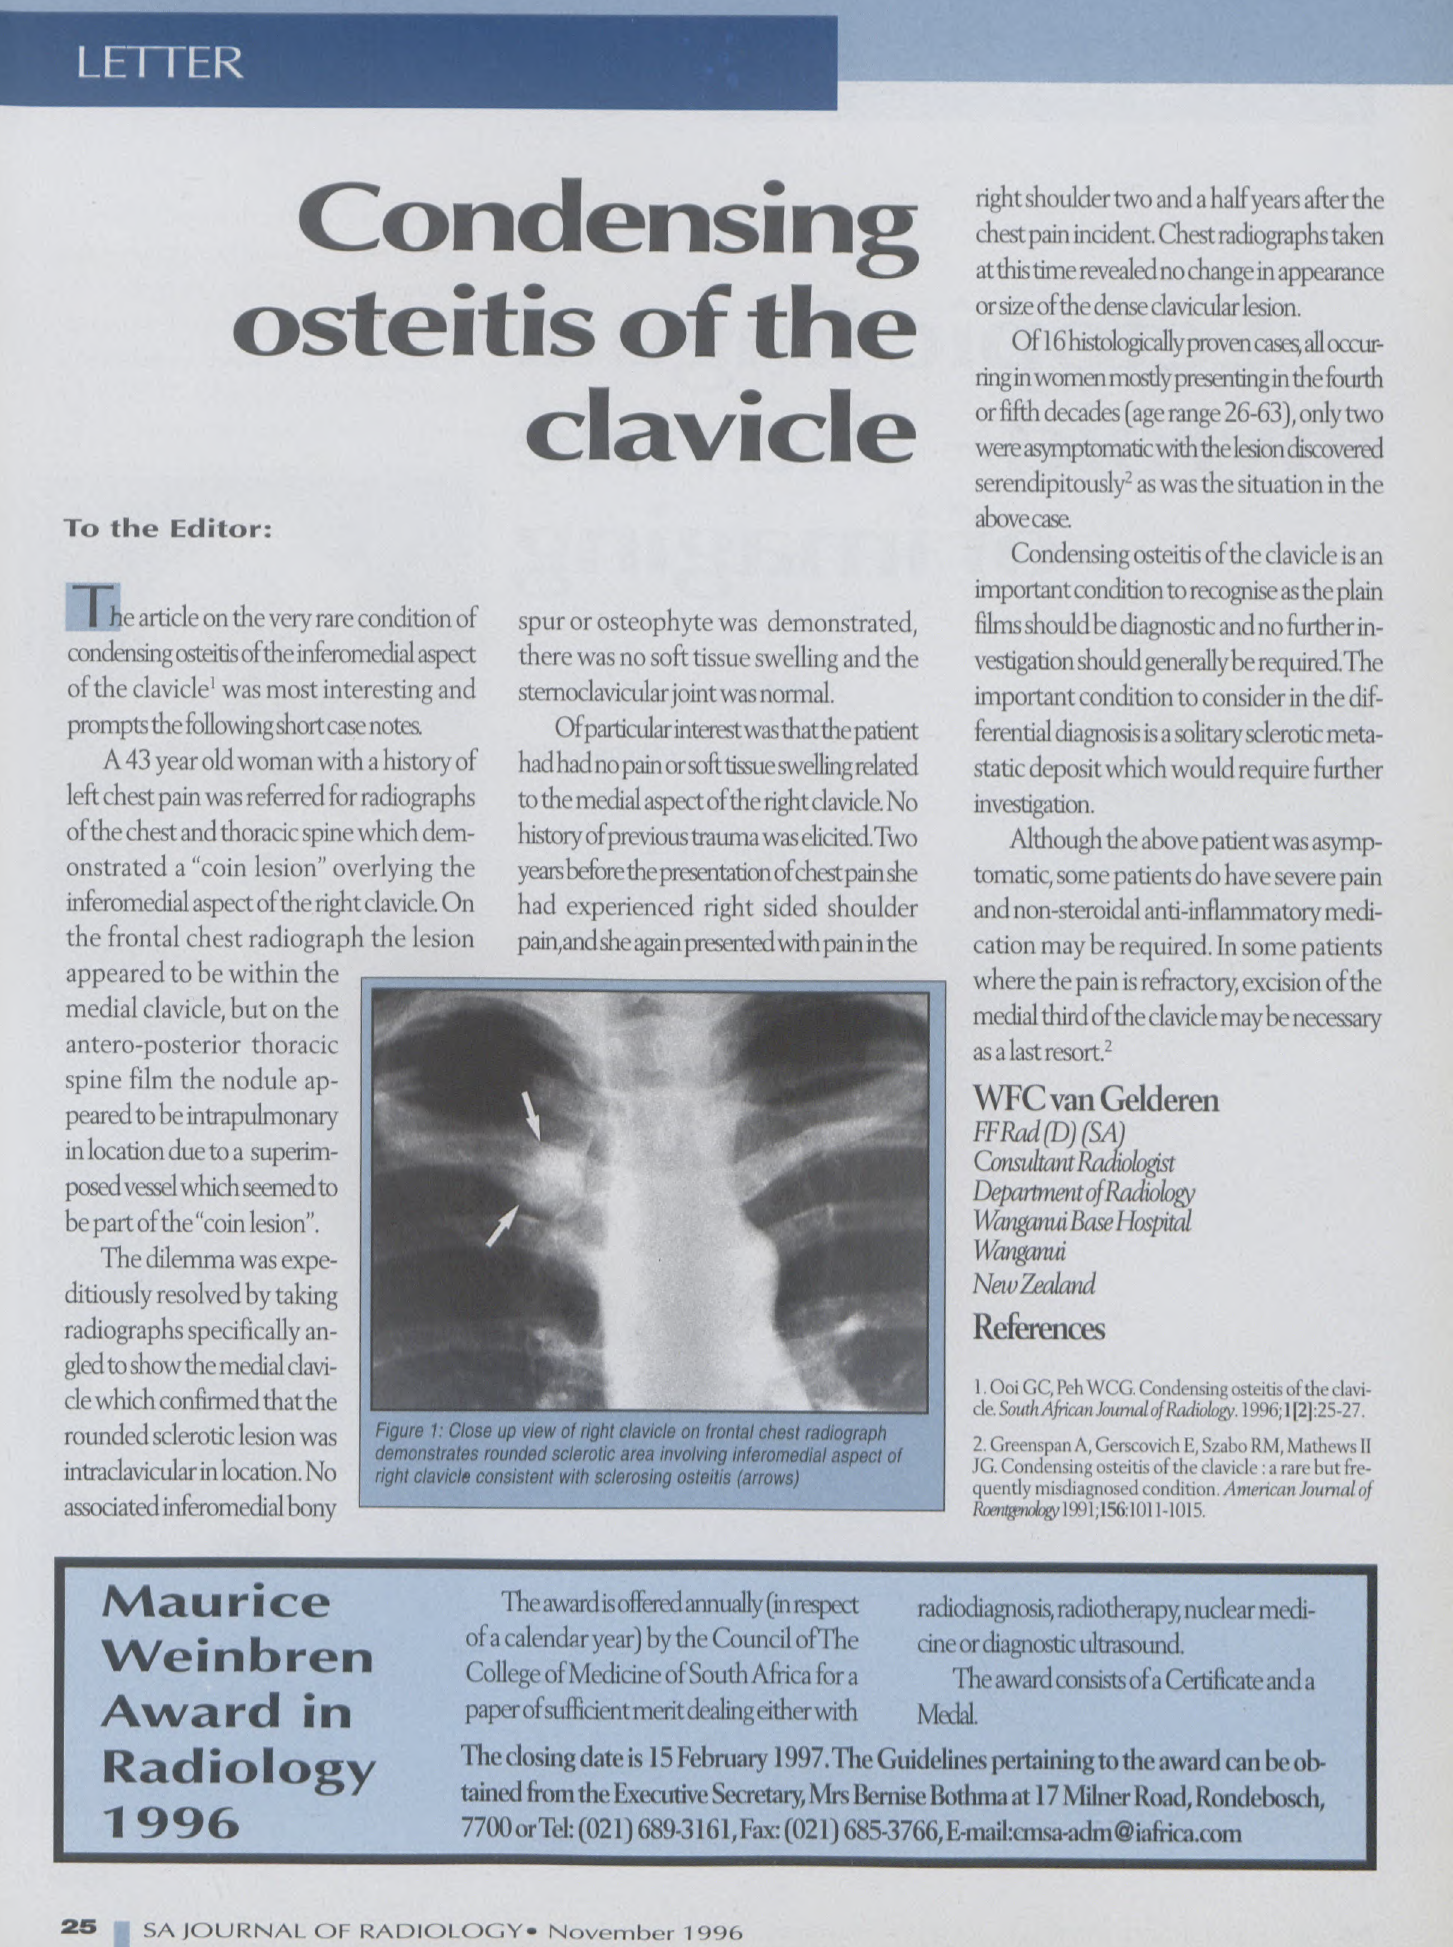
Figure 1: Close up view of right clavicle on frontal chest radiograph demonstrates rounded sclerotic area involving inferomedial aspect of right clavicle consistent with sclerosing osteitis